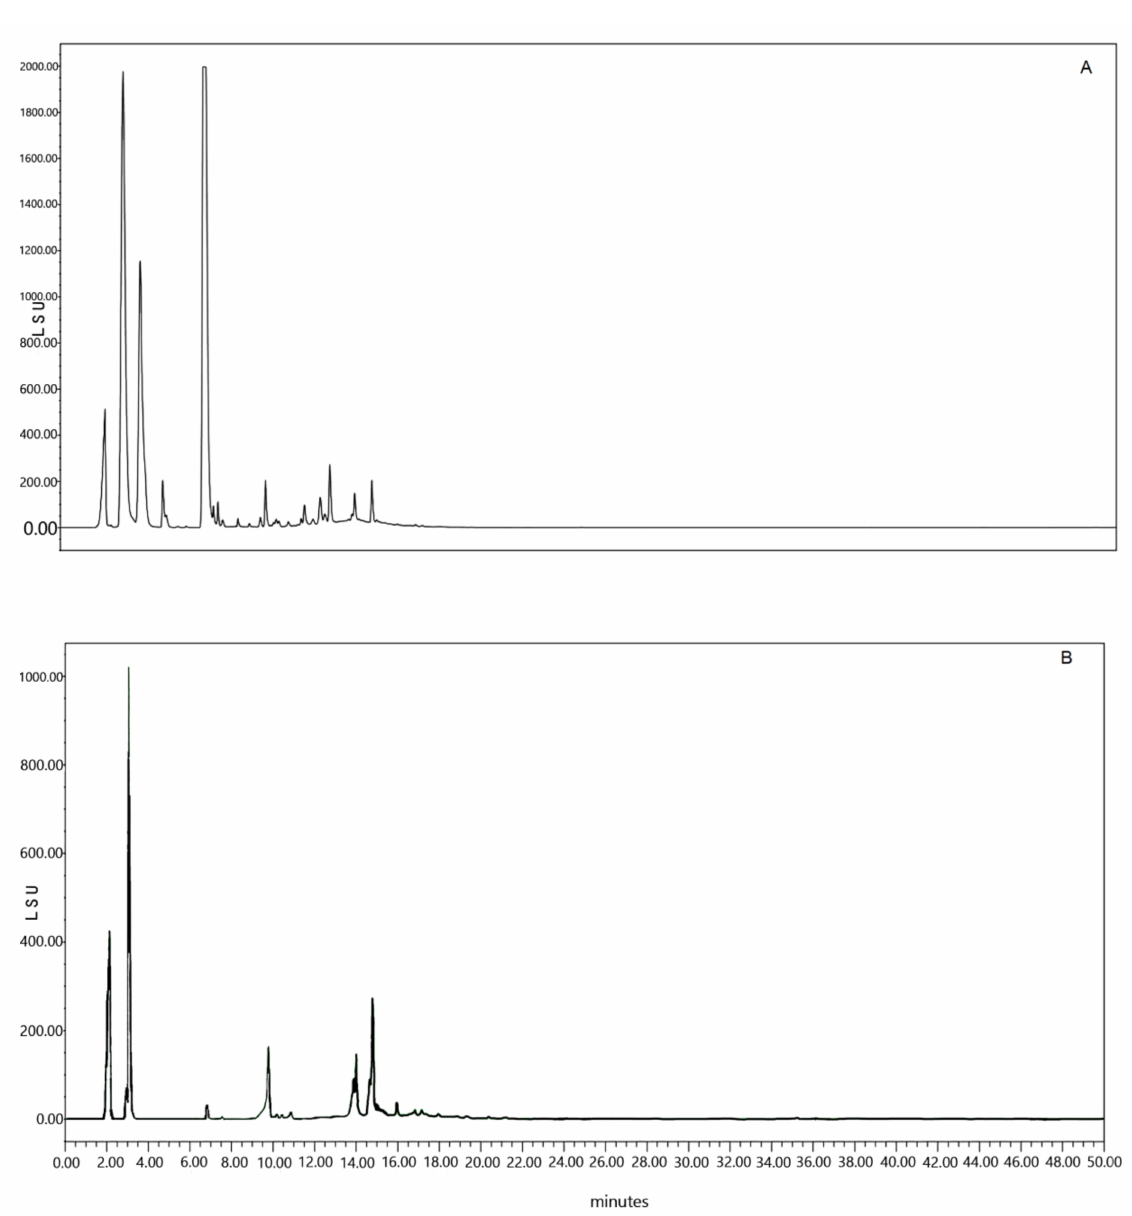
Figure 1. ( A ) HPLC analysis of Arbutus unedo roots aqueous extract obtained by Zippertex apparatus. ( B ) The aqueous extract of A. unedo roots adsorbed by the amberlite